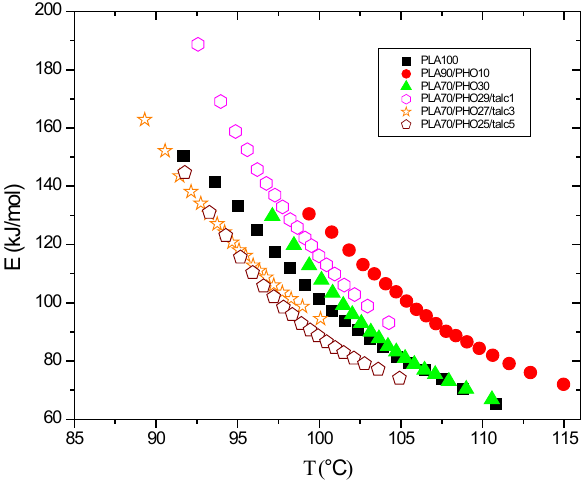
Figure 6: Dependence of the activation energy for crystallization, E , on the temperature, obtained for heating rates, Φ in range 1-7°C/ α min for neat PLA and its blends.